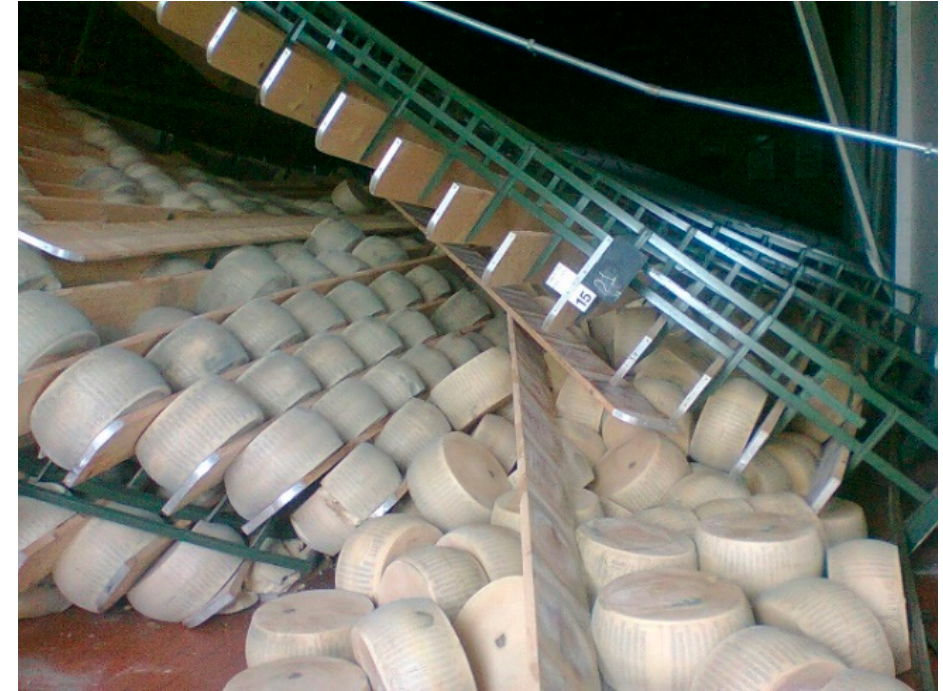
Figure 1. Typical old cheese racks collapsed after the Emilia Romagna earthquake (2012).